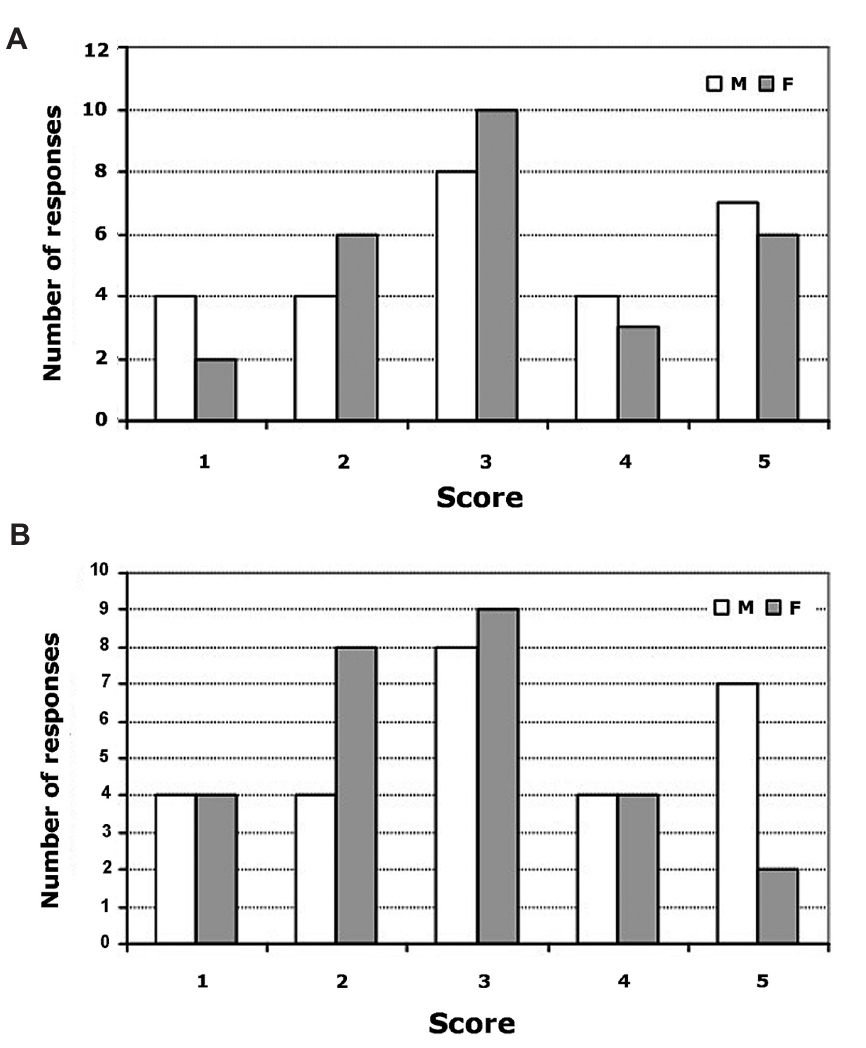
Figure 2 – Distribution of patient and partner responses on a 1-5 scale (ex.: 5 - very high, 4 - high, 3 - moderate, 2 - low, 1 - very low or not at all). M - male patients, F - female partners. Erection / arousal domain. A) Question 1 (patient) / 1 (partner): “Over the last 4 weeks how would you rate the level of your erection/arousal during sexual activity or intercourse?”. B) Question 2 (patient) / 2 (partner): “Over the last 4 weeks, how would you rate the level of your/your partner’s